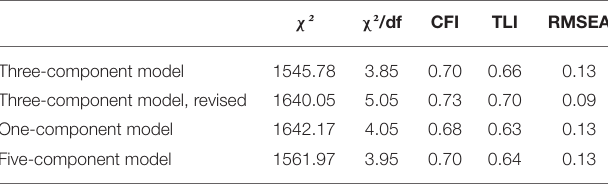
TABLE 6 | Model fit statistic for the respective CFA models. χ ² χ ² /df CFI